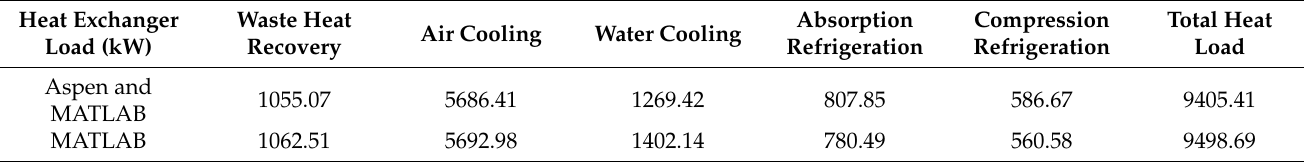
Table 9. Heat exchanger load of cascade cooling system